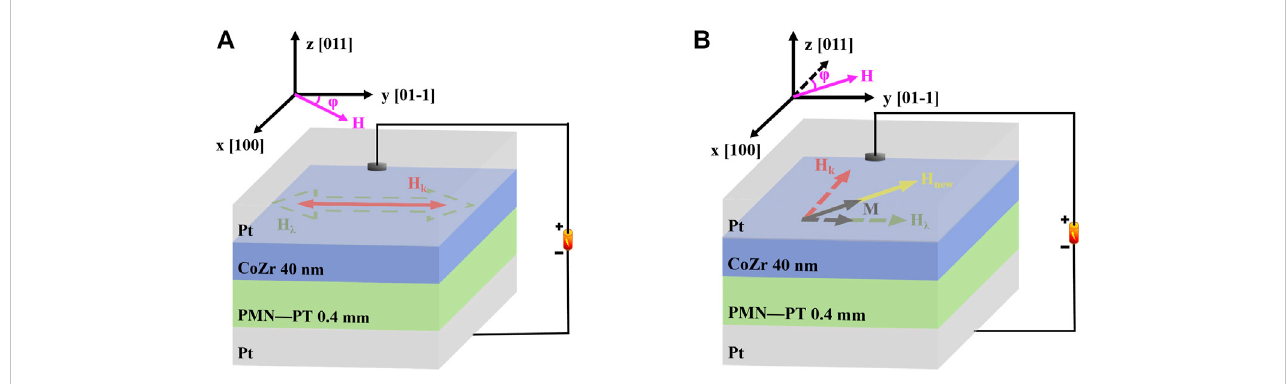
FIGURE 2 Schematicof magnetic uniaxial and piezostrain anisotropy for theCoZr layer along (A) (01 – 1)and (B) (100)of thePMN – PTsubstrate. φ is the angle of the applied magnetic fi eld with respect to the direction of easy axis at P 0